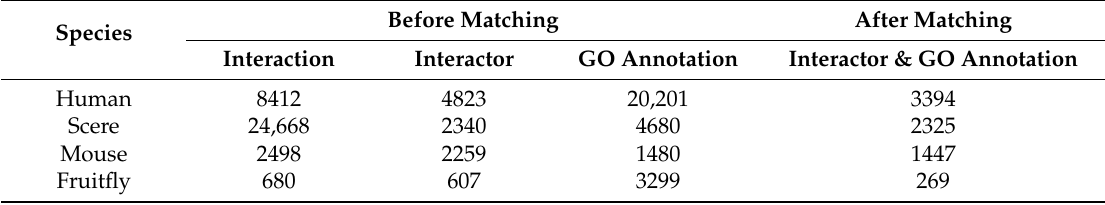
Table 3. Matching statistics 1 .